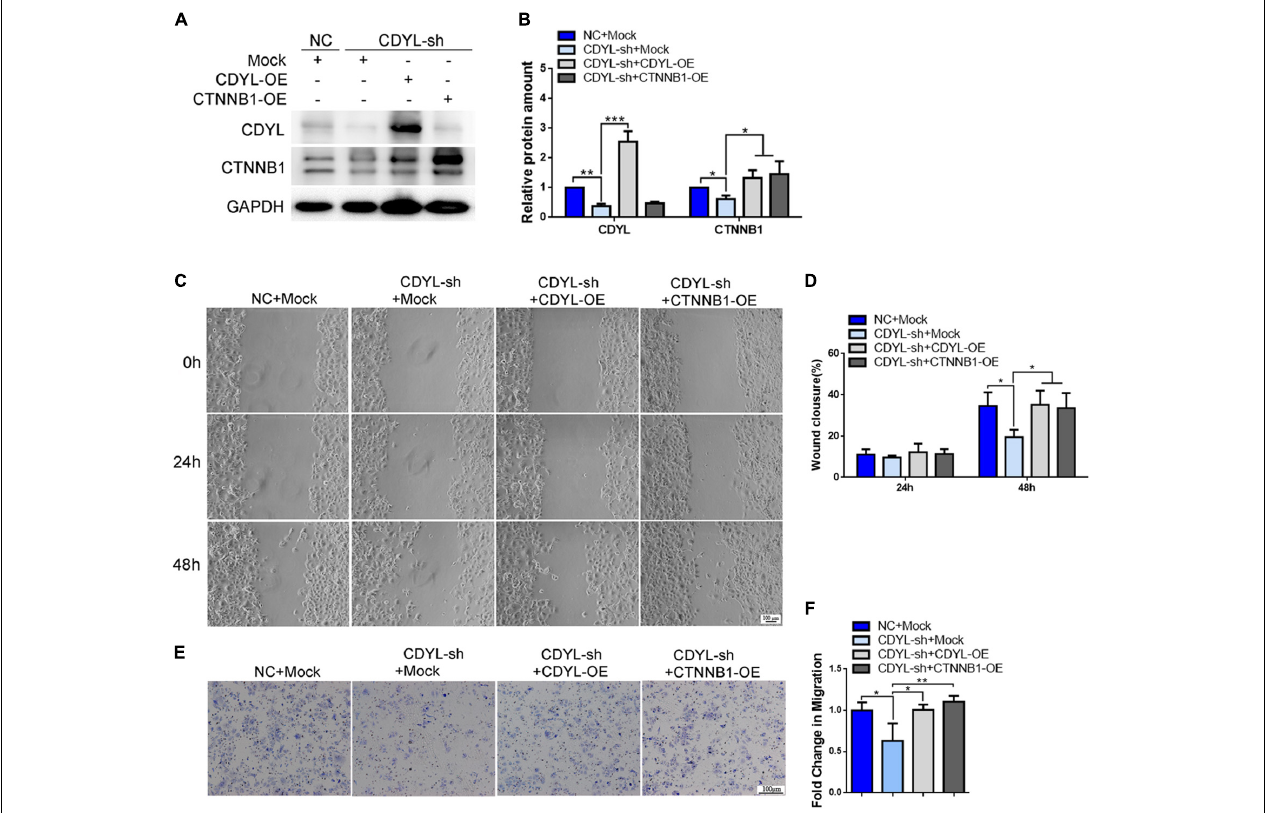
FIGURE 7 | Effects of CDYL knockdown/over-expression on CTNNB1 expression and cell migration in Ishikawa cells. (A,B) Effects of CDYL on CTNNB1 expression level in Ishikawa cells by Western blot analysis ( n = 3). Effects of CDYL on cell migration in Ishikawa cells by wound-healing assay (C,D) and transwell migration assay (E,F) . Bar = 100 µ m. N = 3. All data are presented as mean ± SD. * P < 0.05; ** P < 0.01; *** P <